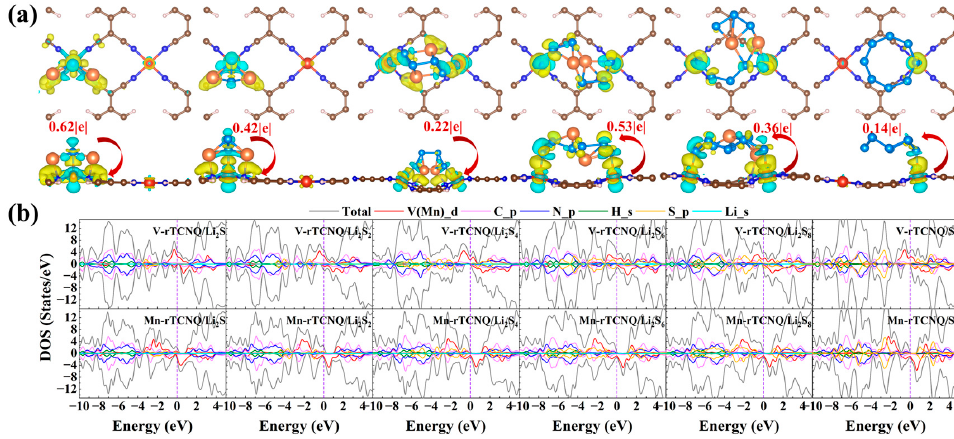
Figure 3. ( a ) The charge density differences and the charge transfer amount of the adsorption sys- tems of V-rTCNQ for S 8 /LiPSs. ( b ) The total and projected DOS of V-rTCNQ and Mn-rTCNQ after anchoring S 8 /LiPSs clusters. Fermi-level in the violet dotted line is set to be zero.